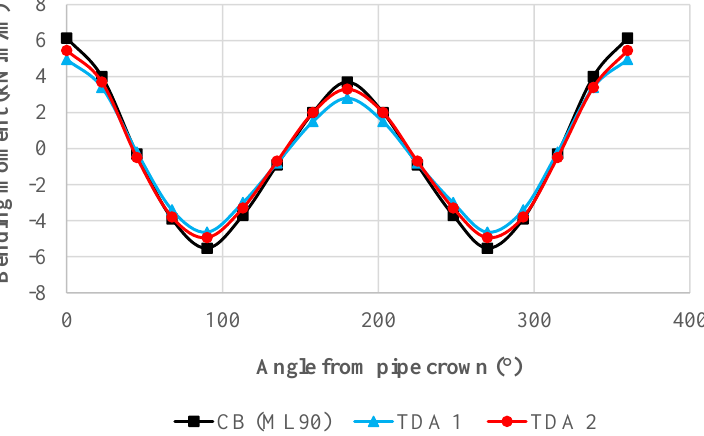
Figure 6. Comparison of the bending moment developed in the pipe wall for conventional backfill using ML90, TDA 1, and TDA 2 for ML90 backfill.